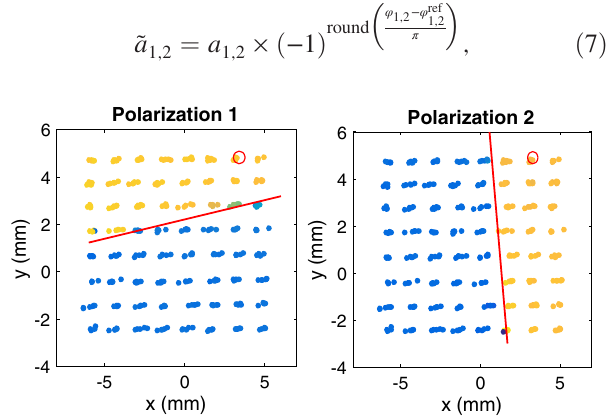
FIG. 13. Phases of the two polarizations as a function of the beam position. The phase of Polarization one is about 1.1 rad for the yellow points above the axis and − 2 . 0 rad for the blue ones below the axis. The phase of Polarization two is about 0.9 rad for the yellow points on the right and − 2 . 2 rad for the blue ones on the left. The phase difference between the points on the different sides of the polarization axis is approximately π . The red circle marks the position where the reference phases are